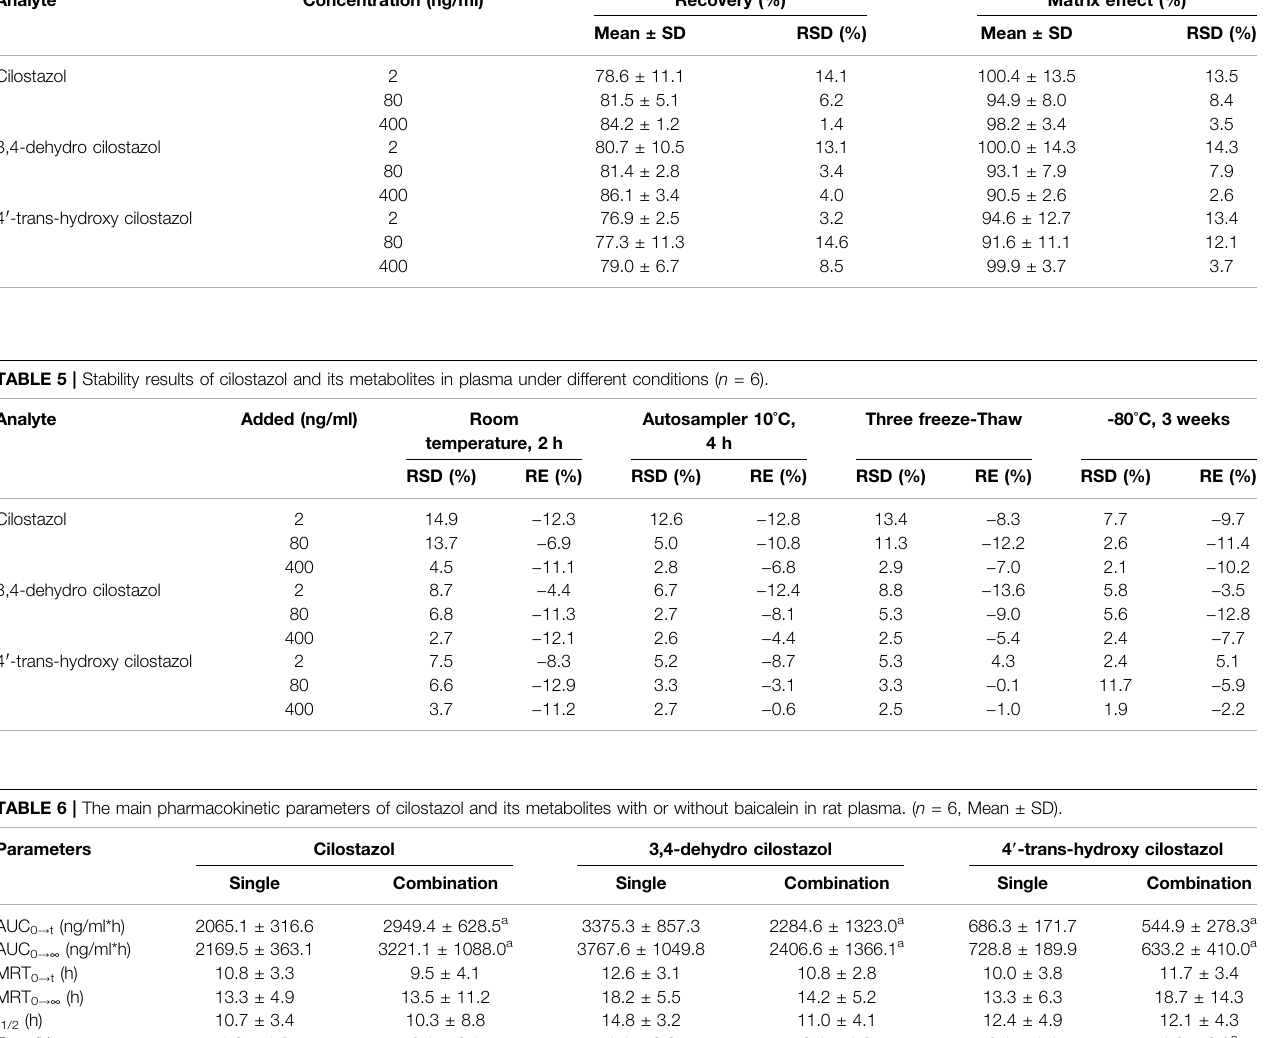
TABLE 4 | Recovery and matrix effect of cilostazol and its metabolites in rat plasma ( n = 6). Analyte